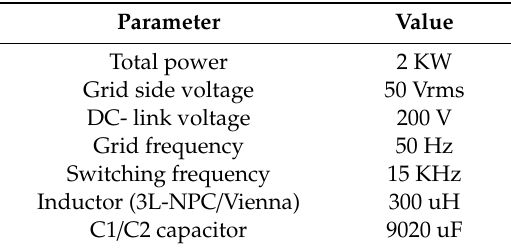
Table 4. Data used for Simulation and Experiment.